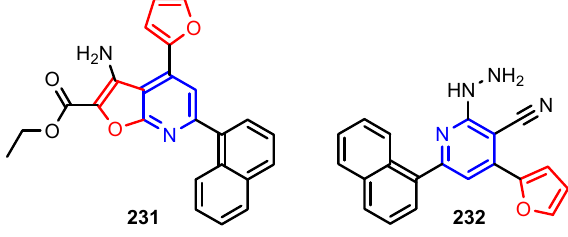
Int. J. Mol. Sci. 2022 , 23 , 5659 Figure 25. Structures of compounds 231 and 232 [103]. Figure 25. Structures of compounds 231 and 232 [103].